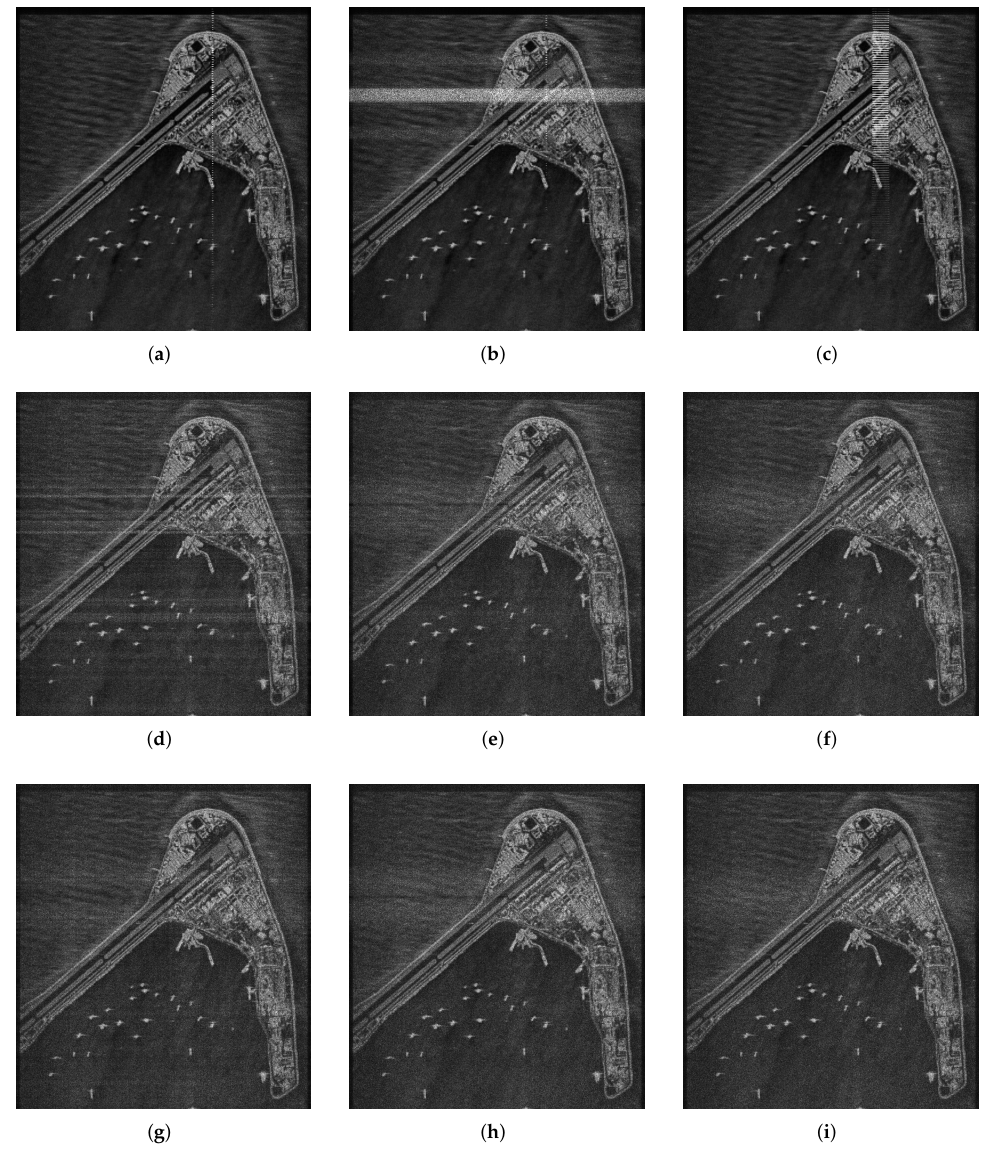
Figure 13. Simulation images of a real scene: ( a ) RSF-LS-DFC SAR with FFSI; ( b ) RSF-LS-DFC SAR with RFSI; ( c ) RSF-LS-DFC SAR with SFSI; ( d ) RSF-IC-DFC SAR with FFSI; ( e ) RSF-IC-DFC SAR with RFSI; ( f ) RSF-IC-DFC SAR with SFSI; ( g ) RSF-DC-DFC SAR with FFSI; ( h ) RSF-DC-DFC SAR with RFSI; ( i ) RSF-DC-DFC SAR with